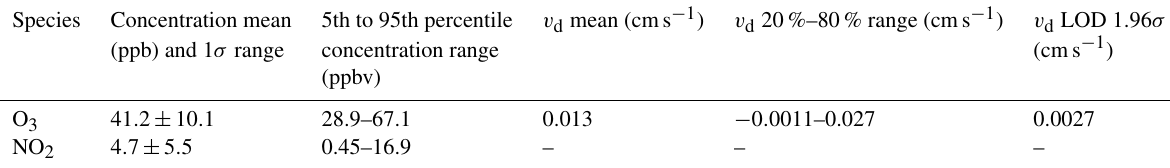
Table 2. Overview of flux and concentration measurements of O 3 and NO 2 from Scripps Pier. Concentration ranges are reported for all periods of onshore winds. Flux results are reported only for final quality-controlled flux periods Ozone mean deposition velocity ( v d ) was well resolved from the campaign ensemble average LOD of 0.0027cms − 1 . Reported v d LOD is the ensemble mean of the LOD determined by the root-mean-square error (RMSE) method at long lag times for each 27min flux period. Of the quality-controlled flux periods, 24% fell below the campaign ensemble LOD. Deposition velocity of NO 2 across the air–sea interface was expected to be small (<0.002cms − 1 ) and was consistently below the LOD of our instrument so no values are reported